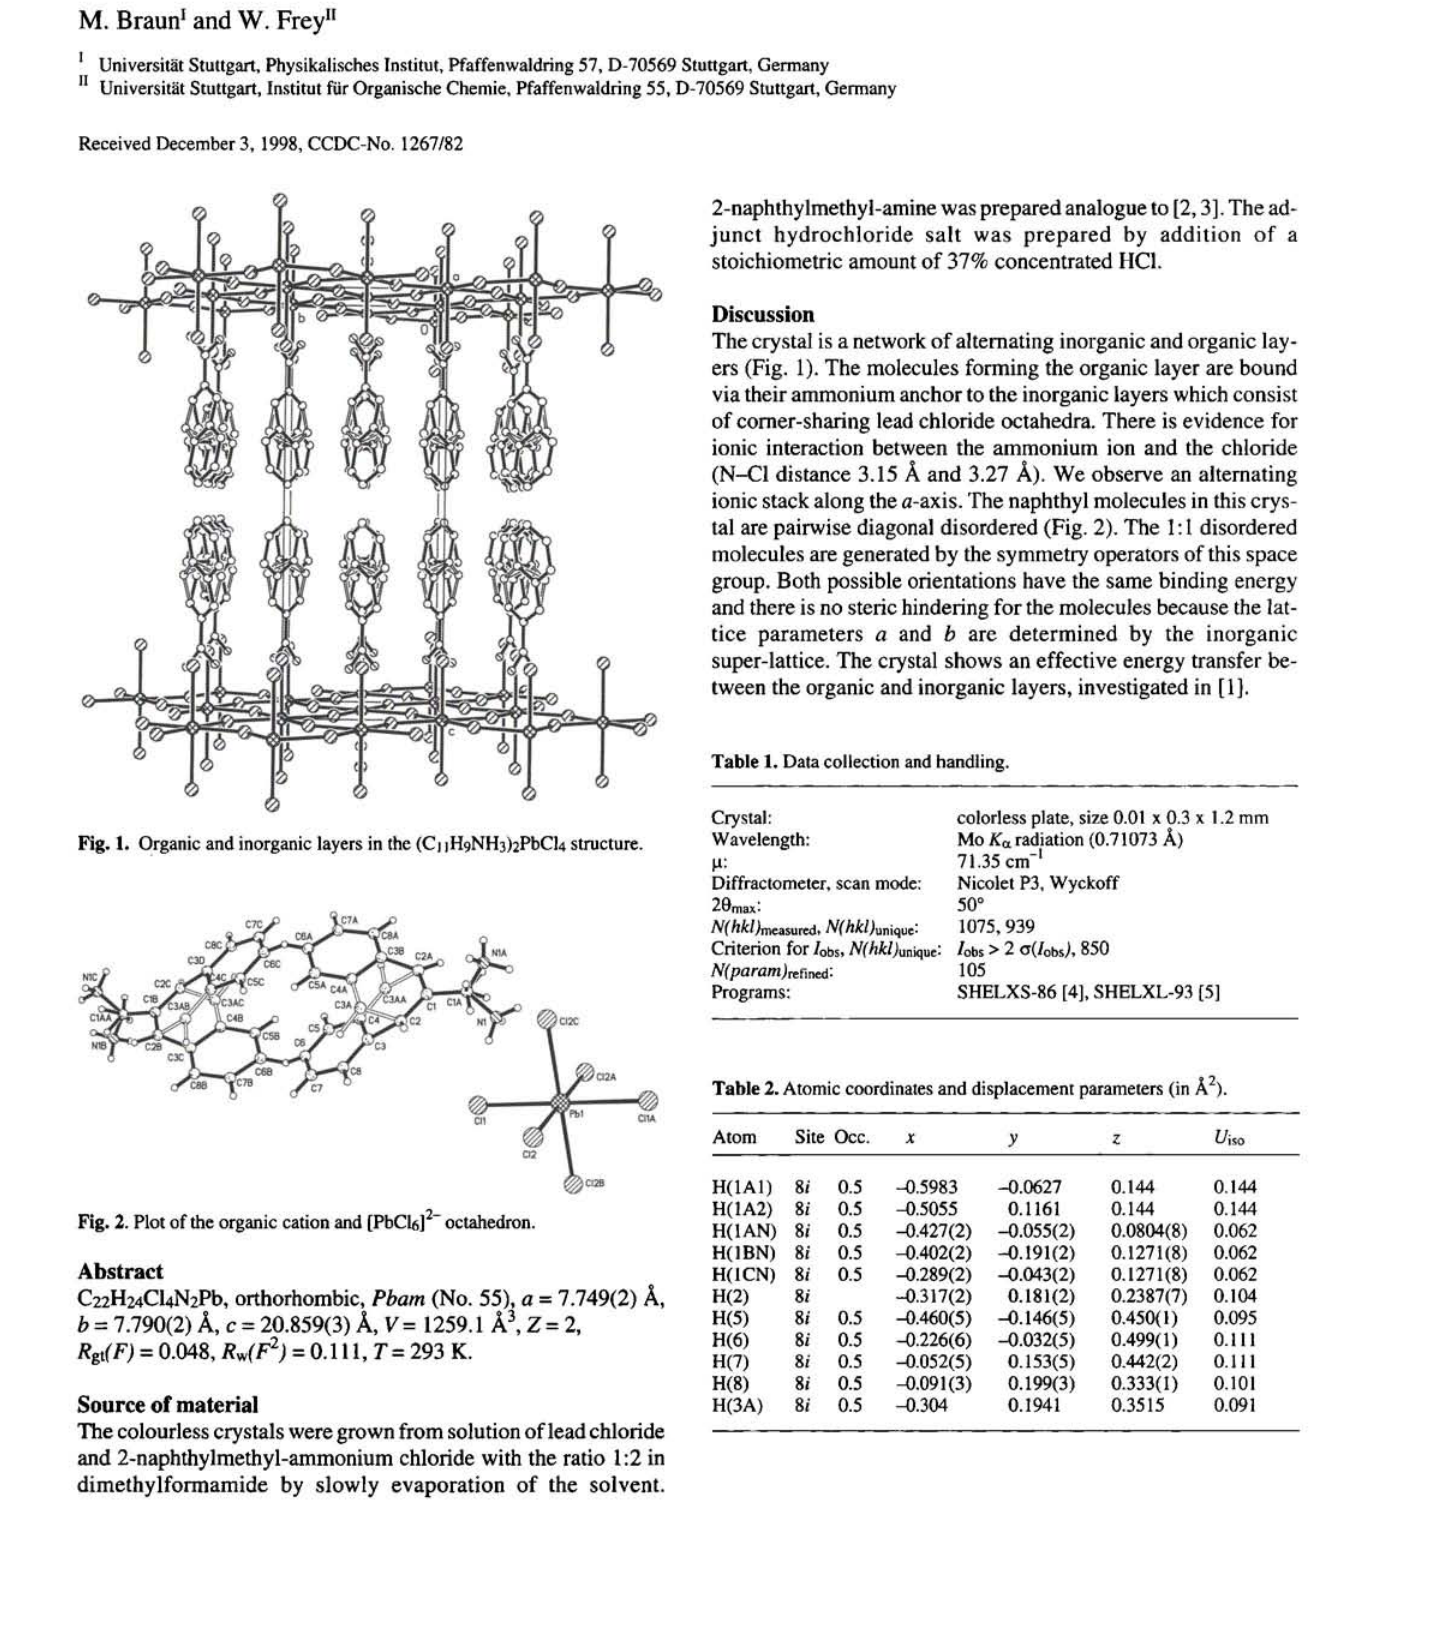
Fig. 2. Plot of the organic cation and [PbCle] 2